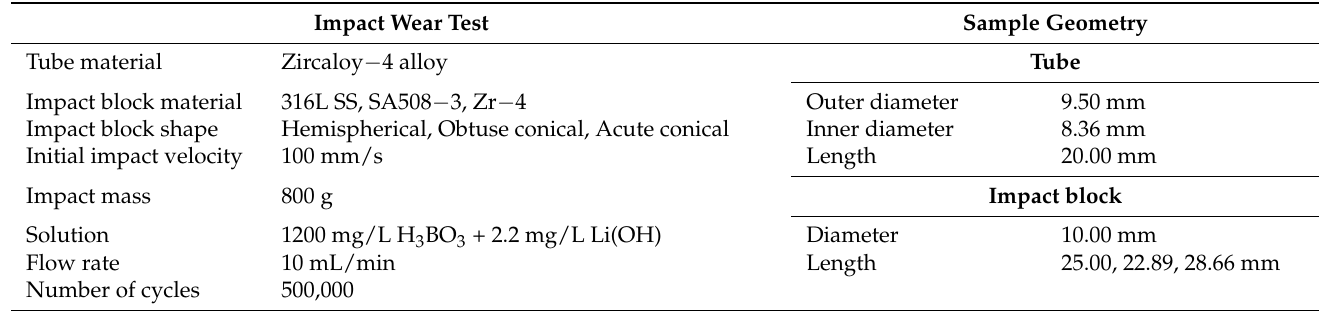
Table 2. Experimental parameters for the impact wear test.